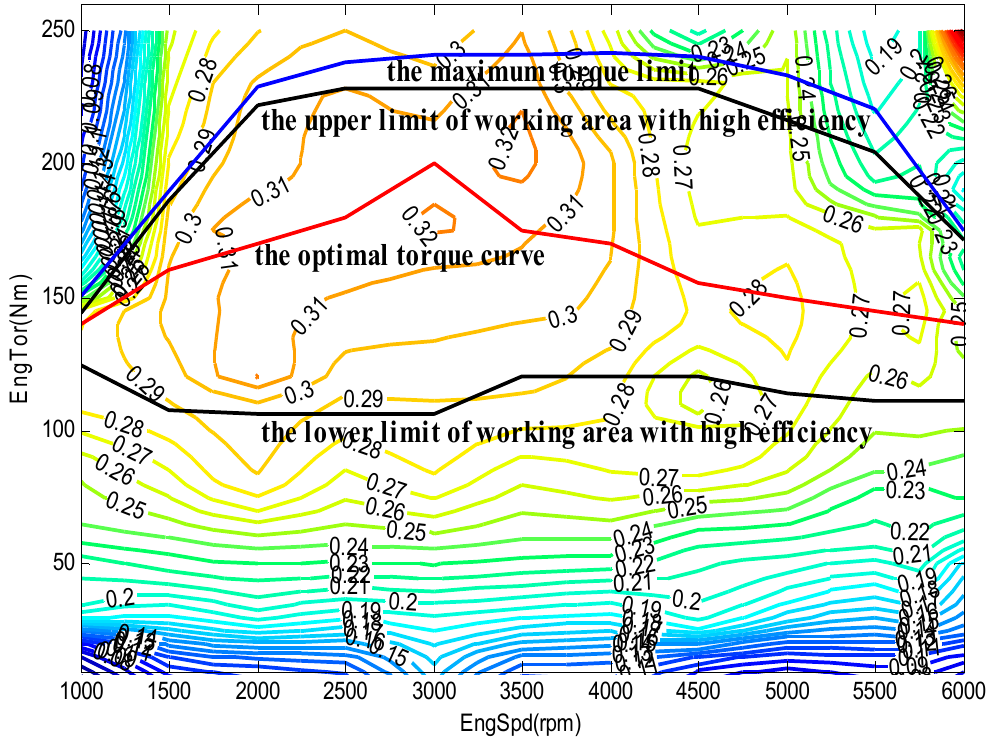
Figure 10. Engine working area division.